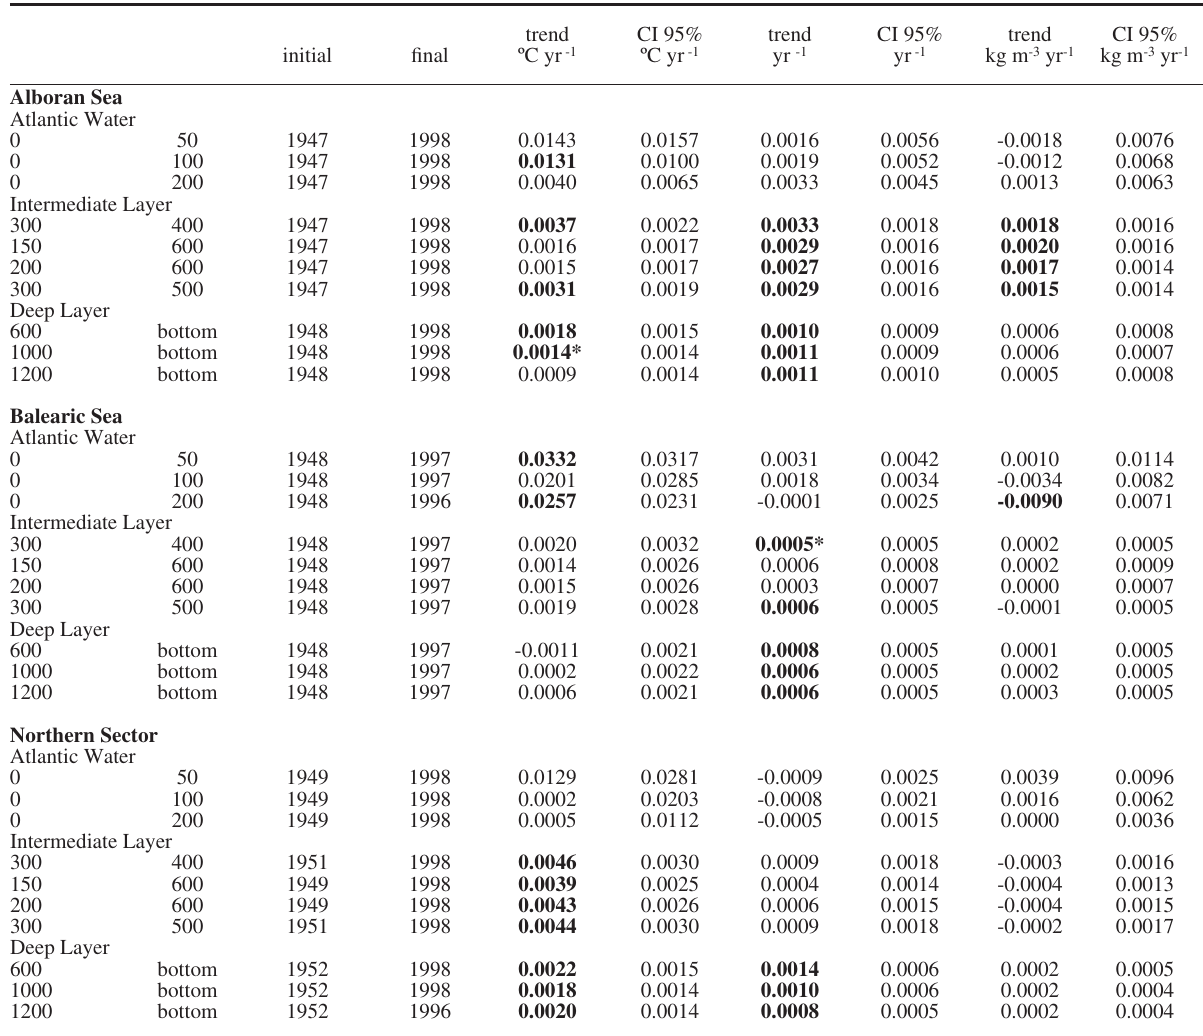
Table 3. linear trends and confidence intervals (95%) for potential temperature, salinity and potential density for the three geographical areas considered in this work and for different definitions of the upper, intermediate and deep layers. Figures in bold are statistically significant at the 95% confidence level and figures in bold with asterisks are marginally significant, that is, at the 90% confidence